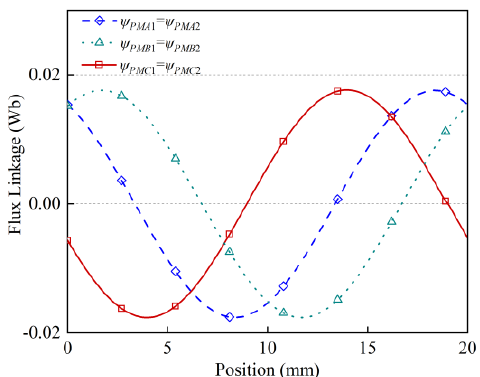
Figure 5. FEM results of the three-phase PM flux linkage of each module varying with position.